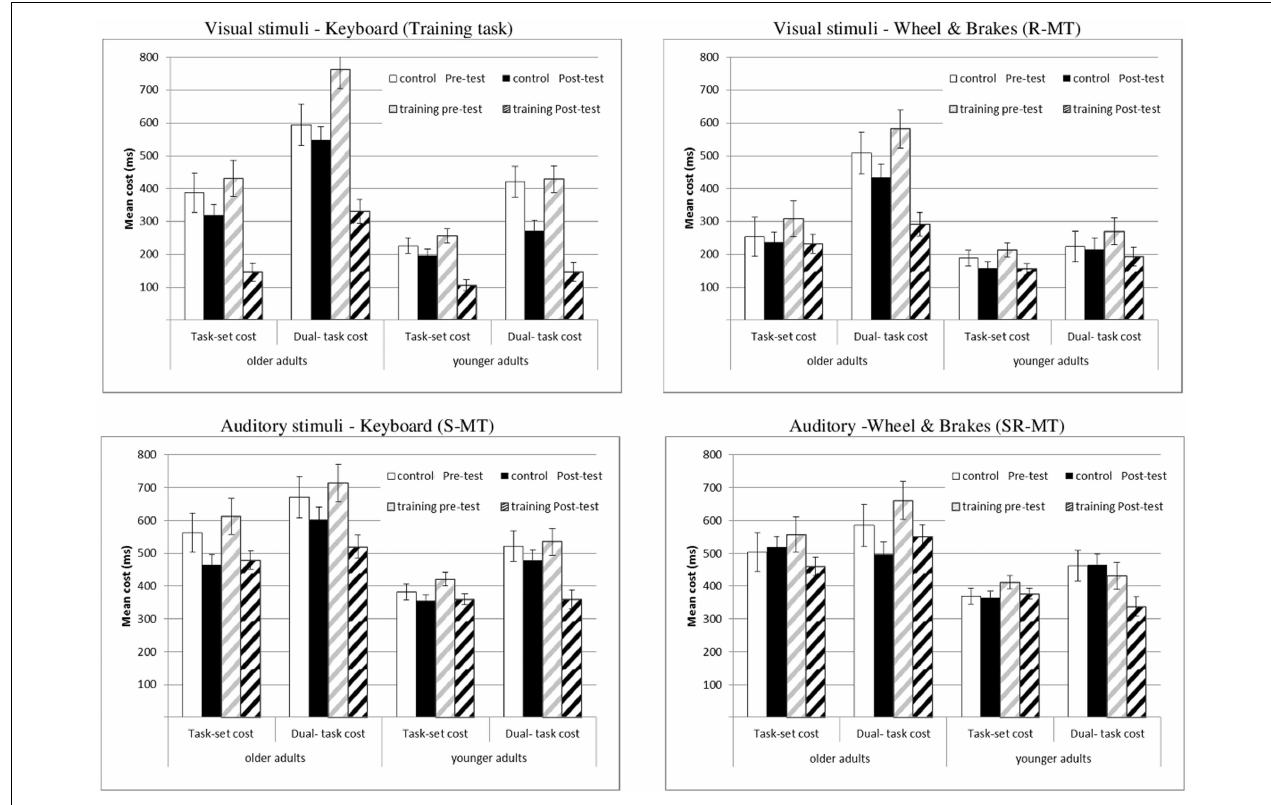
condition (second panel), the stimulus modality transfer (S-MT) dual-task condition (third panel), and the stimuli–response modality transfer (SR-MT) dual-task condition (last